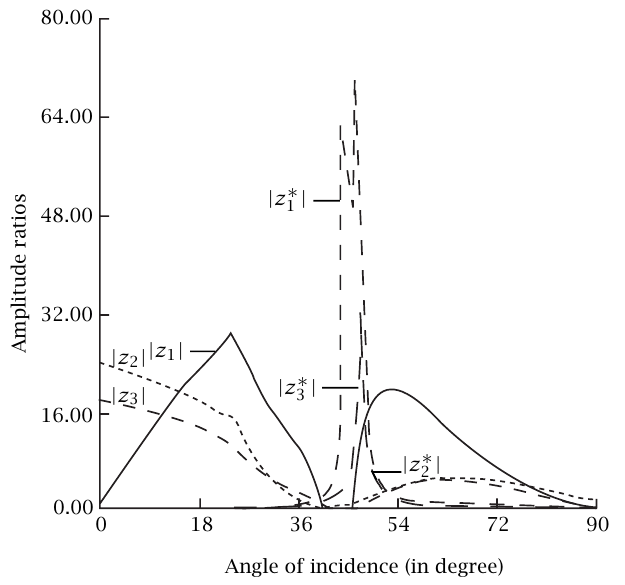
Figure 4.3 . Variation of amplitude ratios with angle of incidence of coupled-wave.